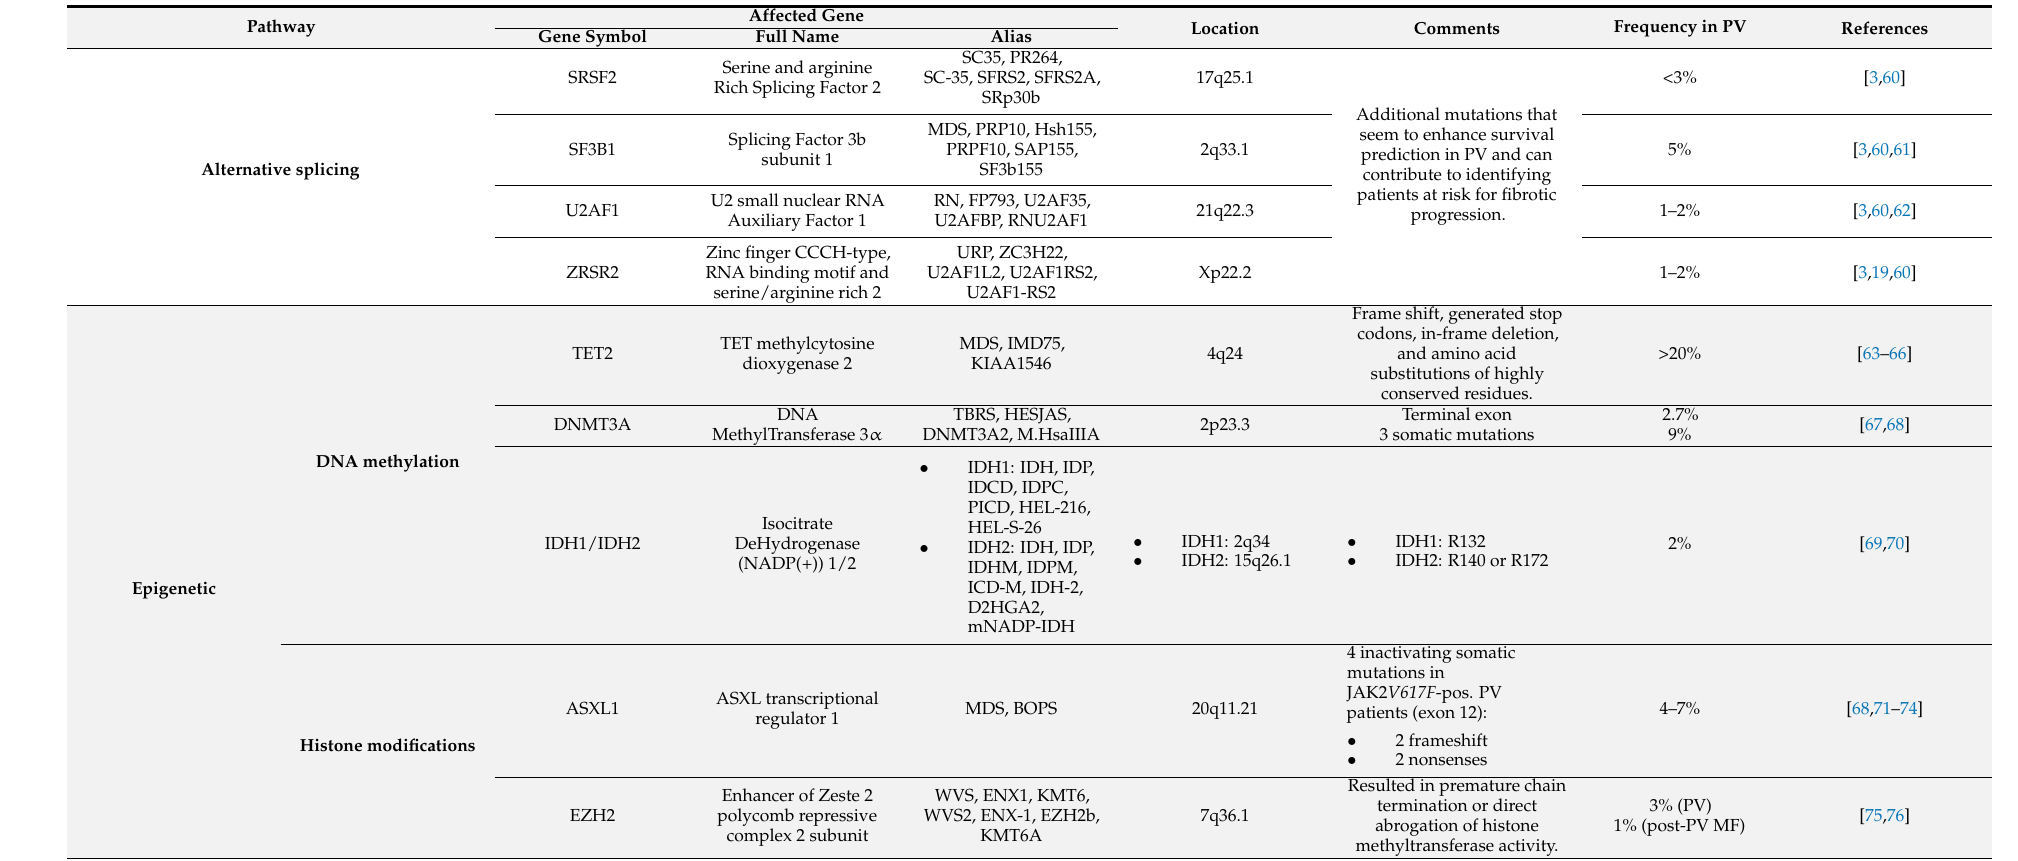
Table 2. Summary of additional mutations in